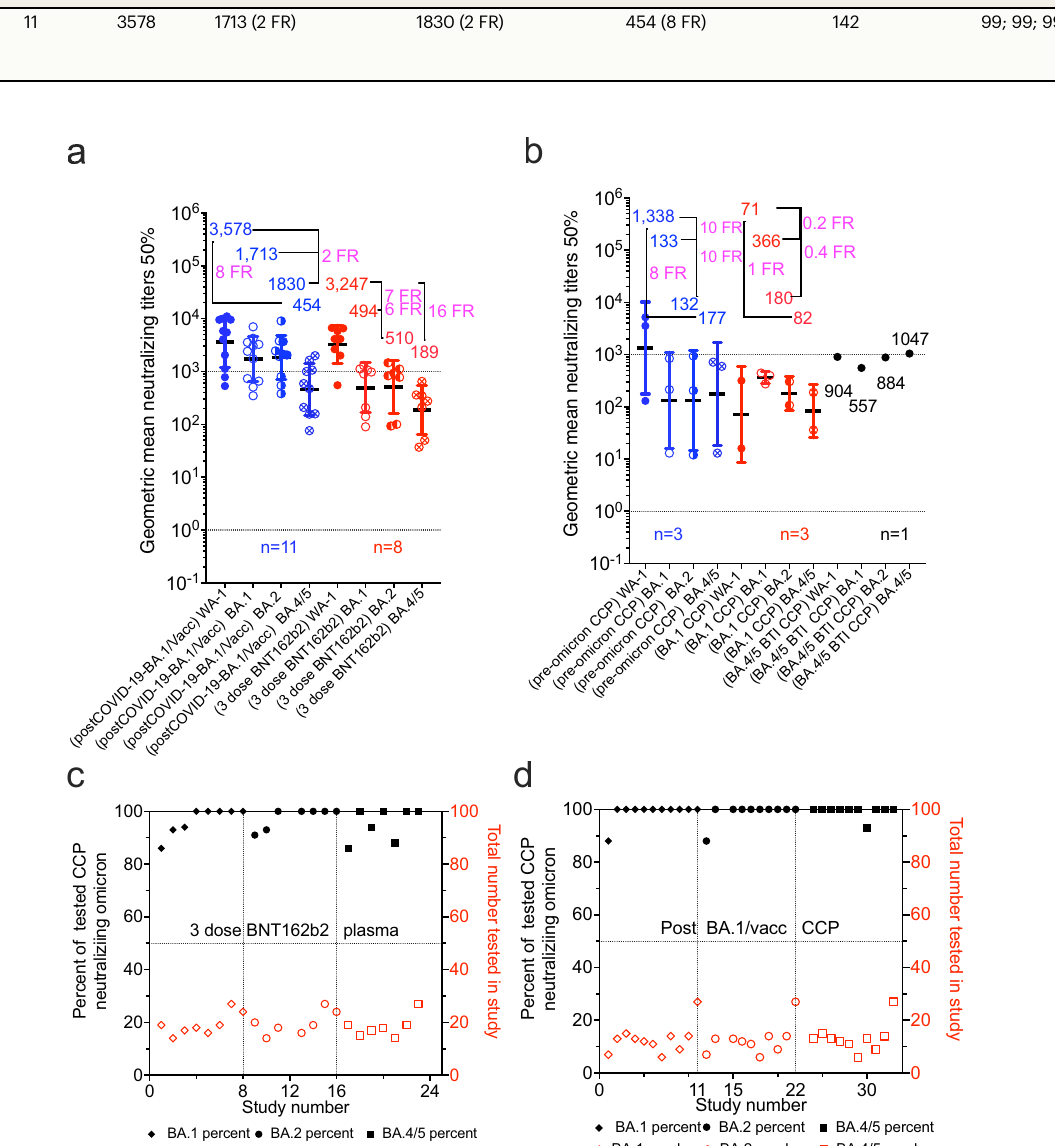
Fig. 5 | Geometric mean neutralizing titers (GMT 50 ) against WA-1 versus Omi- cron BA.1, BA.2, or BA.4/5. a boosted vaccinated plasma with or without BA.1 COVID-19 and b unvaccinated pre-Omicron or BA.1 CCP. Geomeans (geometric standard deviation for error bars), for entire study groups with neutralization of WA-1 in fi lled circles with Omicron in empty circles with geomeans and fold reduction(FR)abovedataandnumberofstudiesabove x axis.Allgeomeansarenot